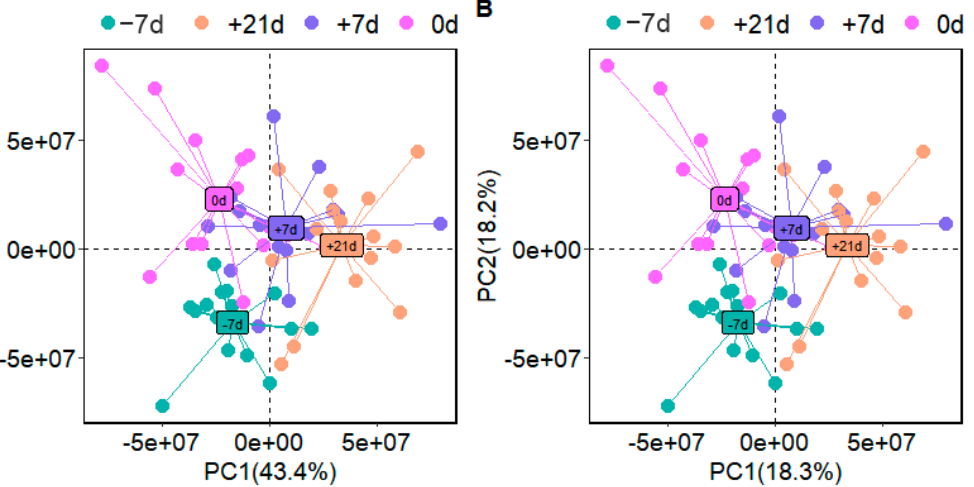
Figure 2. Principal component analysis score plot for − 7, 0, +7, and +21 d samples analyzed in positive ion mode ( A ) and negative ion mode ( B ). PC1—first principal component; PC2—second principal component.